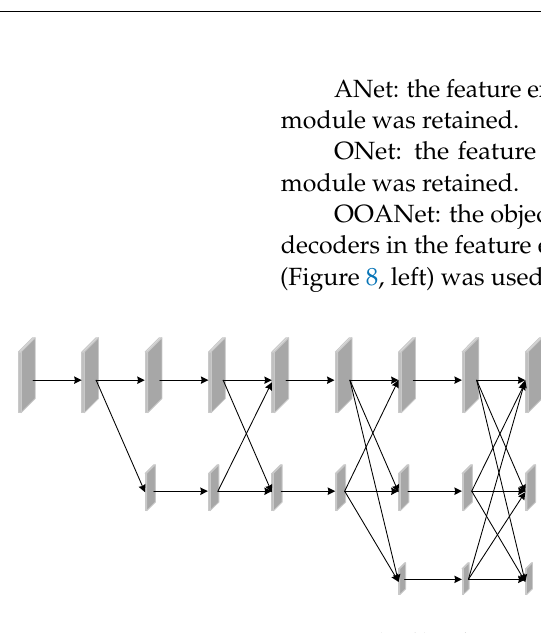
Figure 8. ( Left ): schematic diagram of the HRNet structure; ( Right ): schematic diagram of the ResNet structure.